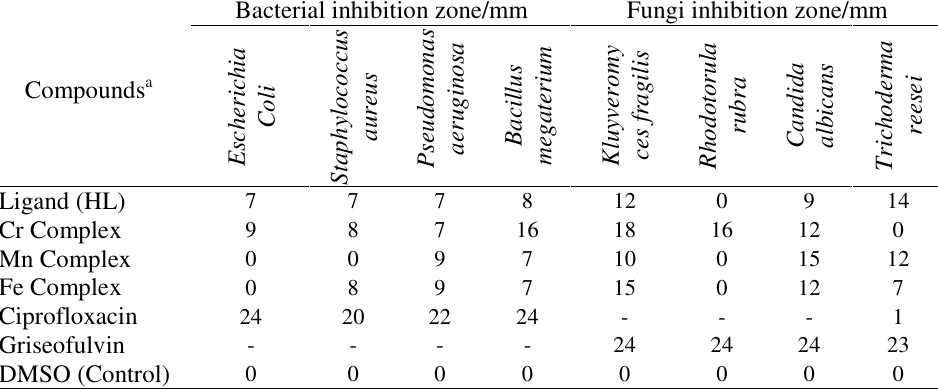
Table 3. Antibacterial and antifungal activity of the standards, solvent, ligand and its metal